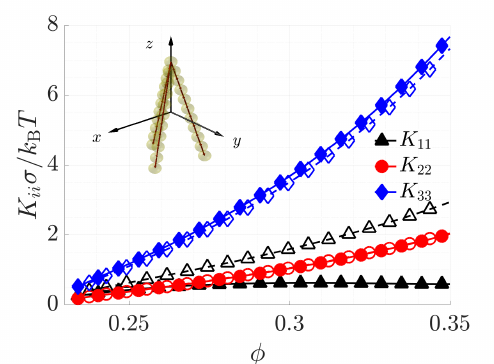
Figure 5. Elastic constants as a function of the packing fraction φ for the tripodal particle shown in the inset. Values calculated using the non-local form of the ODF, Equation (5) (full symbols), and the local form, Equation (6) (empty